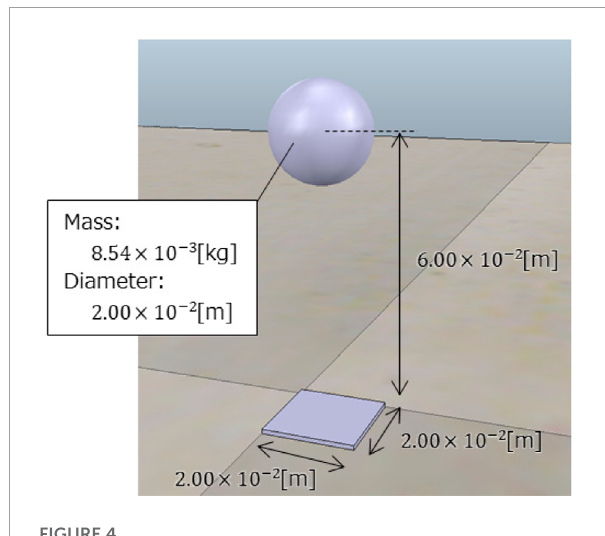
FIGURE 4 One block of the soft floor implemented in the simulator.